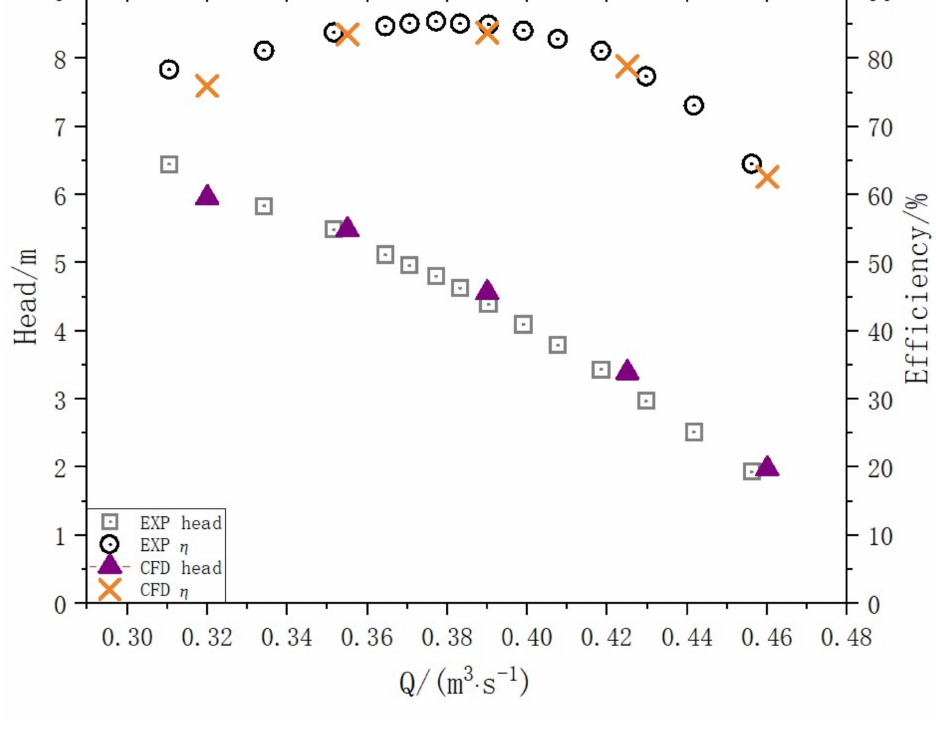
Figure 4. Comparison of model pump external characteristics test and numerical calculation